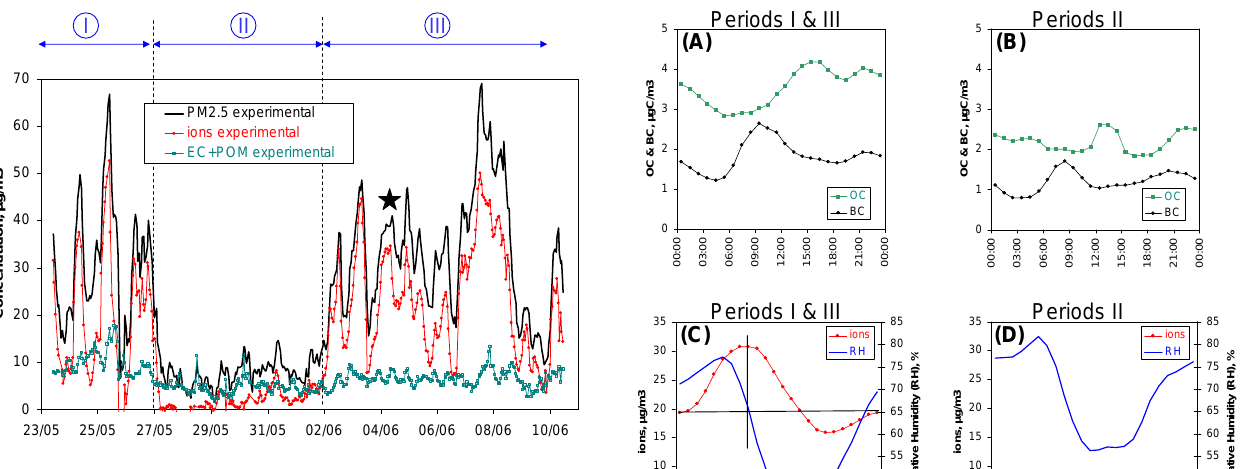
Fig. 5. Hourly PM 2 . 5 concentrations measured by TEOM-FDMS, fine carbonaceous aerosols (EC+POM) and reconstructed fine ions (ammonium nitrate + ammonium sulfate). Periods I and III were influenced by continental (European) air masses; period II was in- fluenced by clean marine air masses. The black star corresponds to the pollution episode (plume case study) depicted in Sect. 5.1.